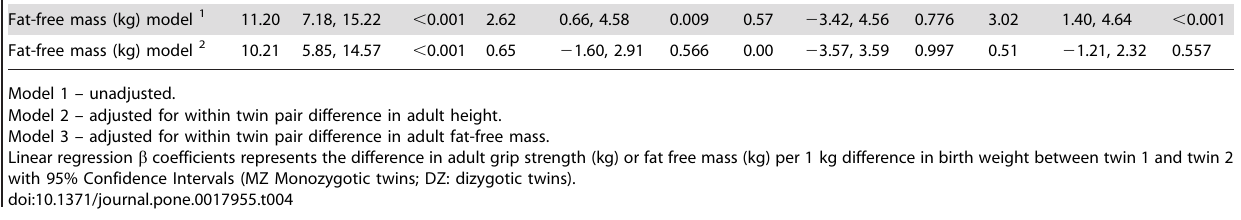
Model 1 – unadjusted. Model 2 – adjusted for within twin pair difference in adult